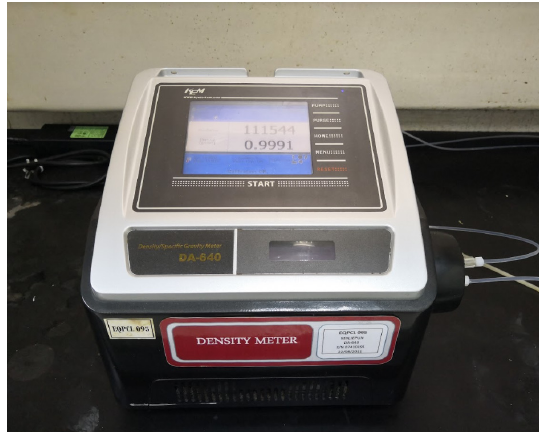
Figure 3. Density Meter model DA-640 series.